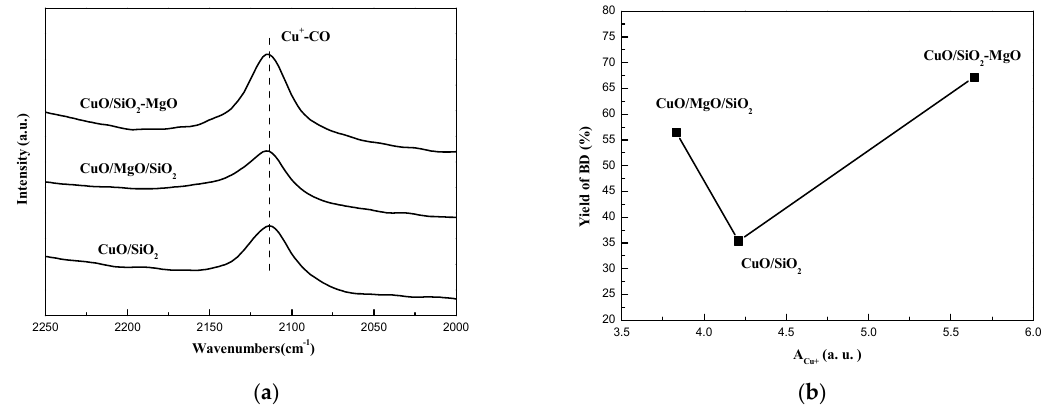
Figure 15. CO-IR spectra of catalysts after reaction ( a ) and Relationship between BD yield and A Cu + ( b ). Stability of the ethynylation catalysts is a critical index for both the practical industrial and academic viewpoints, thus the 5 cycles of evaluation over the prepared catalyts was investigated. As shown in Figure 16a, no apparent decrease in the BD yield was obverved over CuO/SiO 2 -MgO, while the obvious deactivation was found over CuO/MgO/SiO 2 (59.9% to 24.9%) as well as CuO/SiO 2 (43.7%